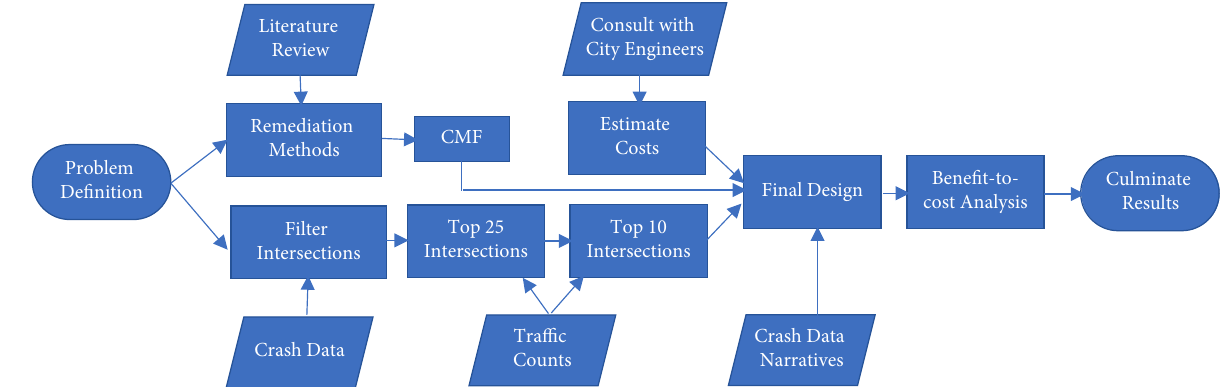
Figure 1: Research methodology for improving intersection safety. Table 1: CMF and cost of 15 safety